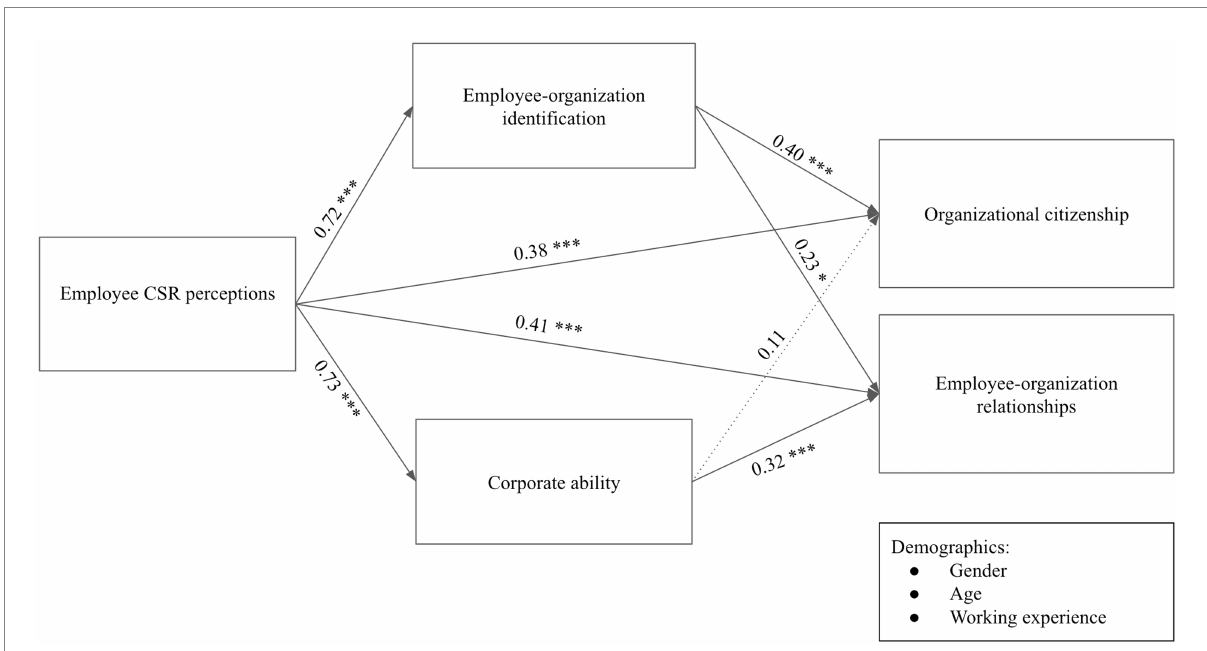
FIGURE 1 Estimated standardized effects in path analysis.